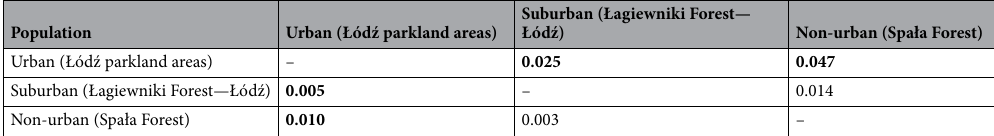
Suburban (Łagiewniki Forest—